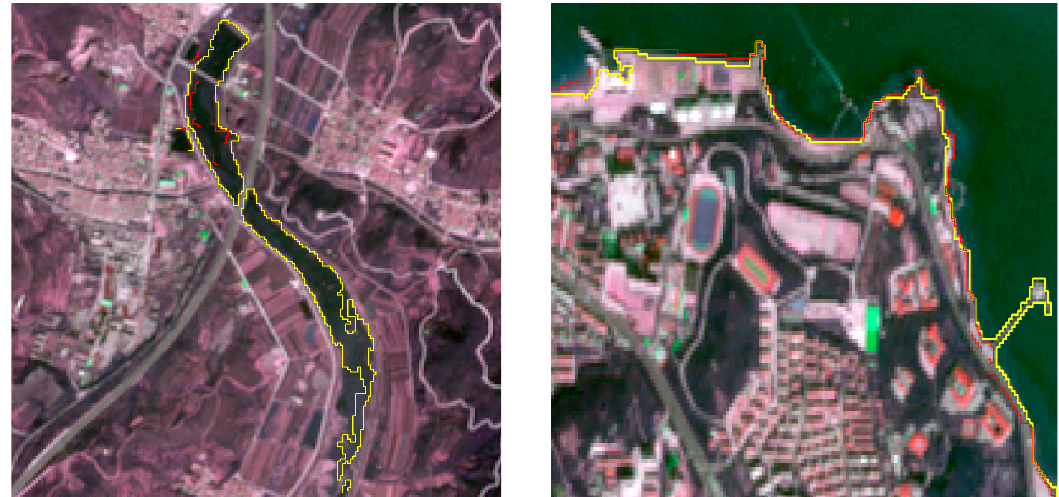
Figure 13. The comparative boundary extraction results of the proposed NDWII method and traditional NDWI method from the Sentinel-2 image (true color synthesis) of Yantai. The yellow lines present the result using the proposed NDWII method, whereas the red lines show the results using traditional NDWI (10 m).